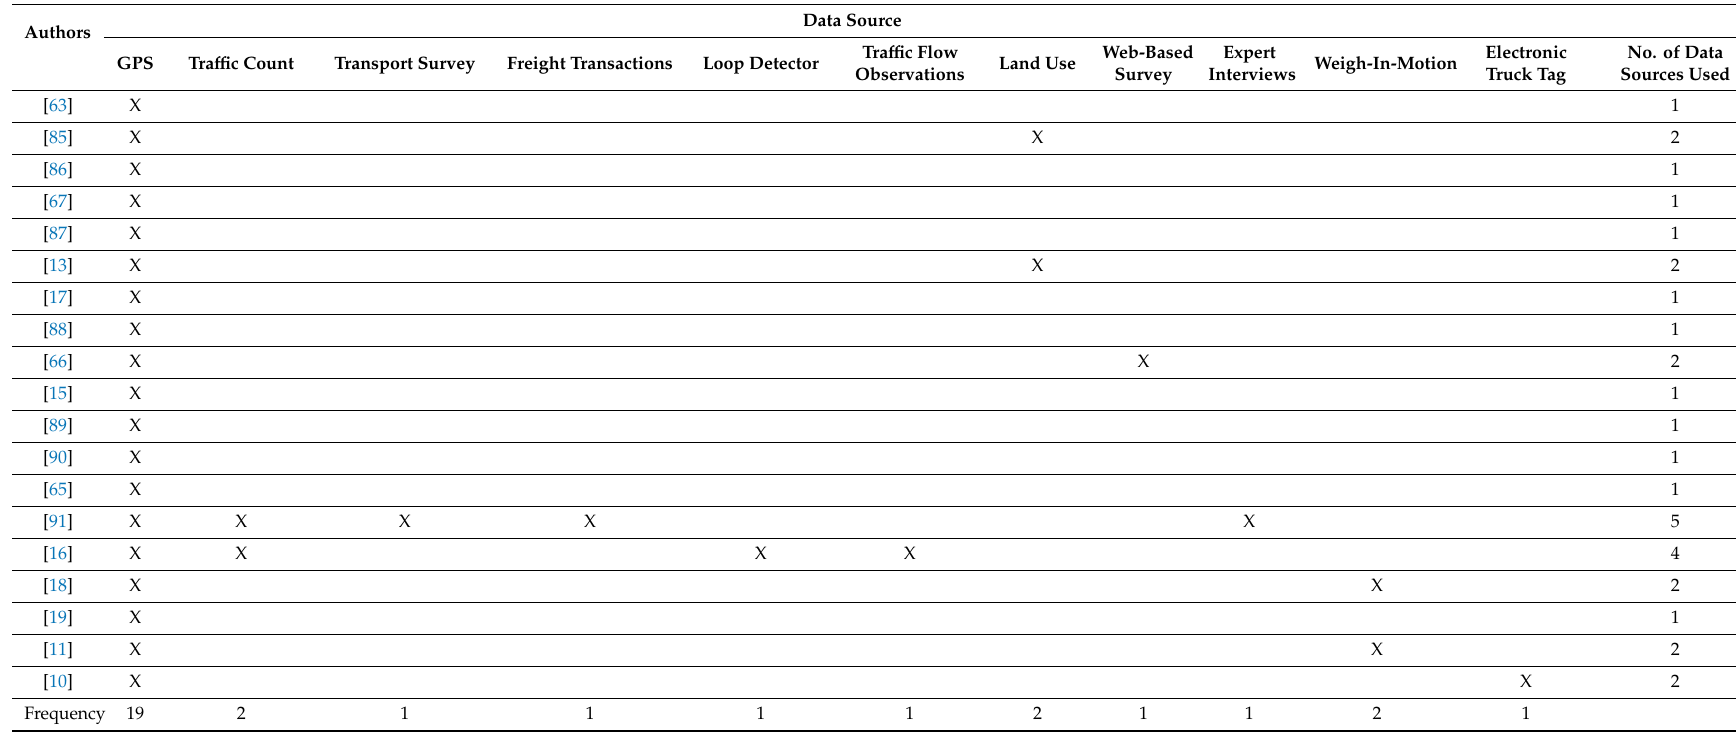
Table 2. Data sources for stop